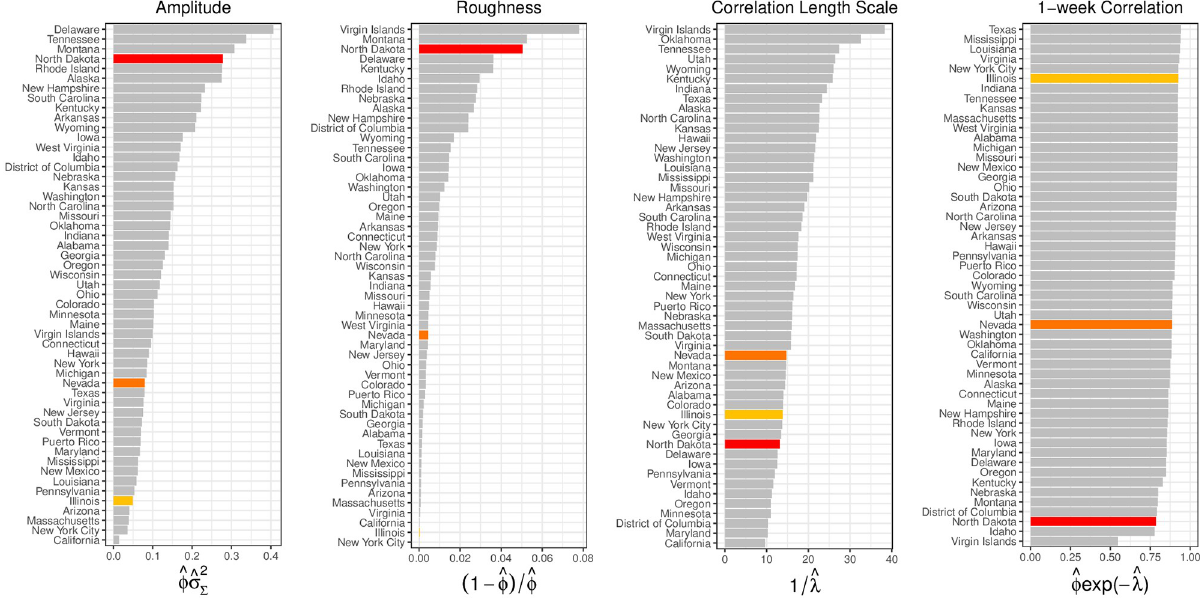
Fig 10. Functions of covariance parameter estimates for all states are presented for North Dakota, Nevada, and Illinois are highlighted in red, orange, and yellow, respectively. North Dakota has larger amplitude (larger ^ � ^ s 2 parameter estimate (similar 1 = ^ l ) and lower 1-week correlation ( ^ � exp ð (cid:0) ^ l Þ closer to 0) than